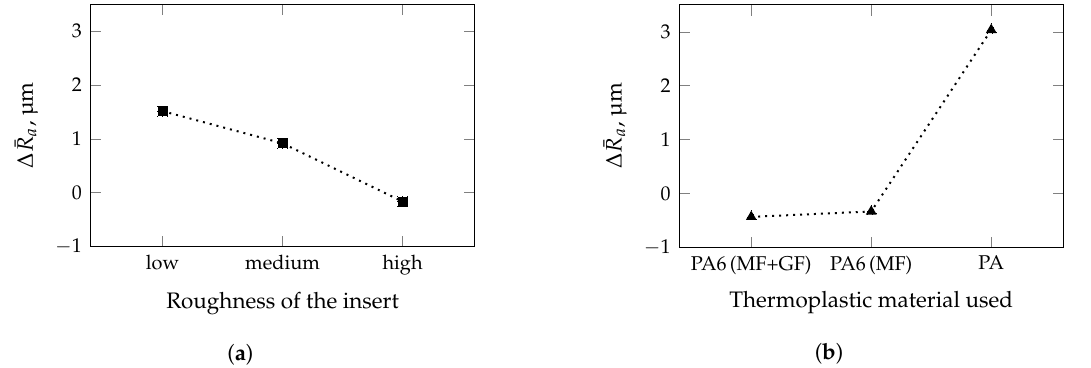
Figure 5. Results of multivariate analysis of variance performed with a confidence interval of 95%. Mineral filler (MF) and glass fiber (GF). Significant change in impression quality ∆ ¯ R a as a function of ( a ) the roughness of the insert and ( b ) the thermoplastic